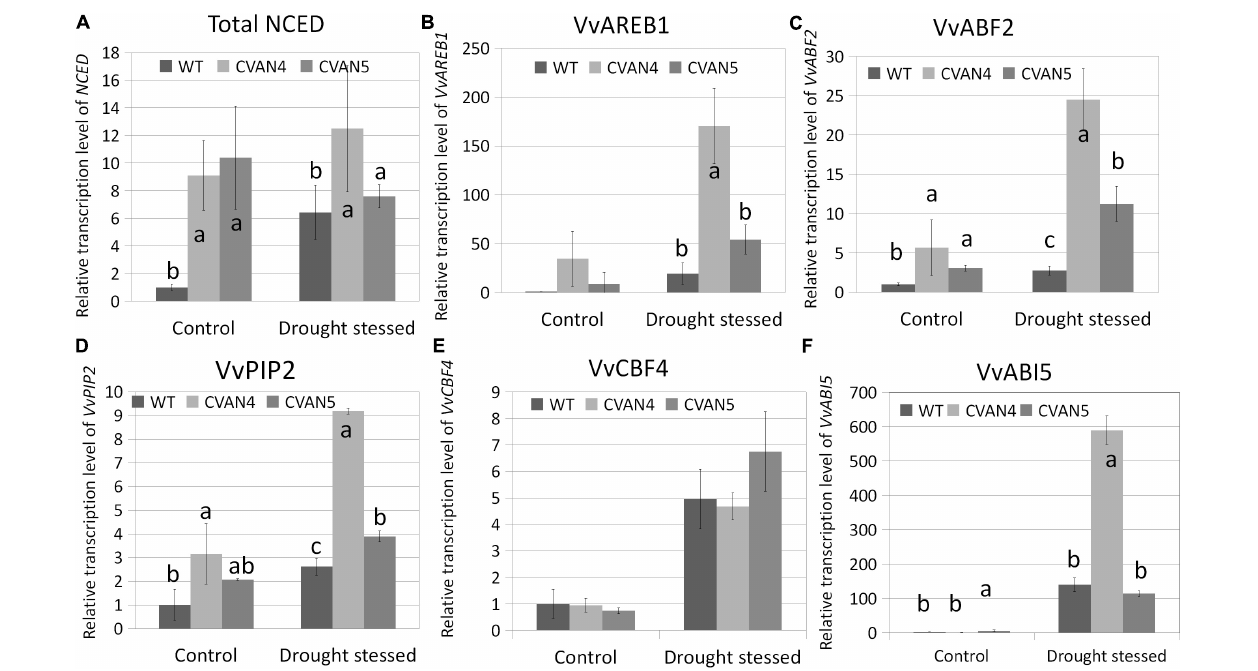
FIGURE 8 | Determination of relative transcript levels of drought-related genes. Total NCED expression (A) , VvAREB 1 (B) , VvABF 2 (C) , VvPIP2 (D) , and VvCBF5 (E) mRNA expression in the WT and transgenic lines under normal conditions and after dehydration for 30 days. The leaves were obtained for the total RNA isolation. EF α and Vitis actin were used as two reference genes for data normalization. Data are expressed as the mean ± SD from 3 independent experiments. Different letters indicate significant differences ( P < 0.05) determined by Duncan’s multiple range test ( P < 0.05) using SPSS statistical software. Gene expression in the WT plants under the same conditions was defined as